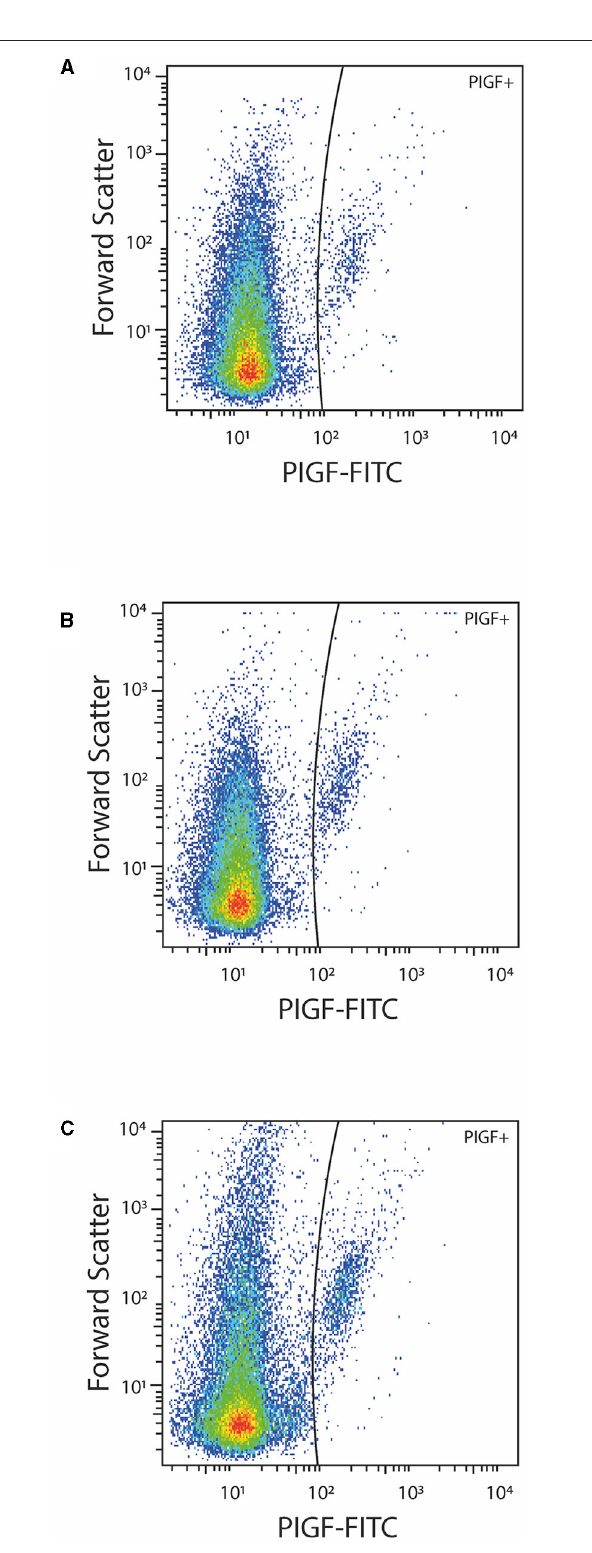
FIGURE 2 | Representative dot-plots of PlGF positive EVs in a healthy pregnant women (A) and a patient with pre-eclampsia before (B) and after (C)